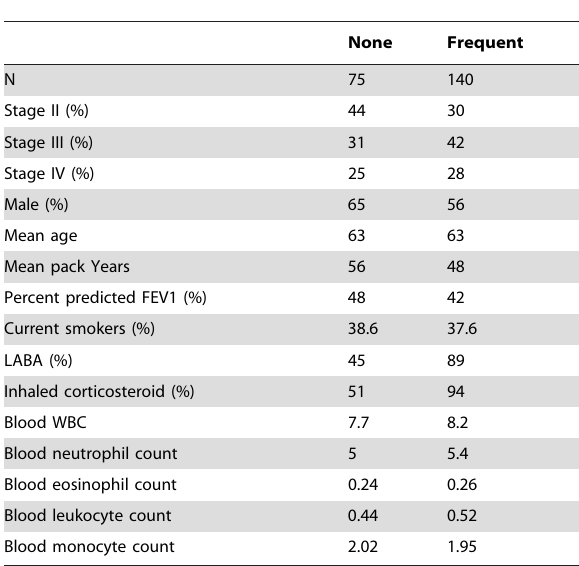
Table 5. Demographics of the COPD subjects for PCR